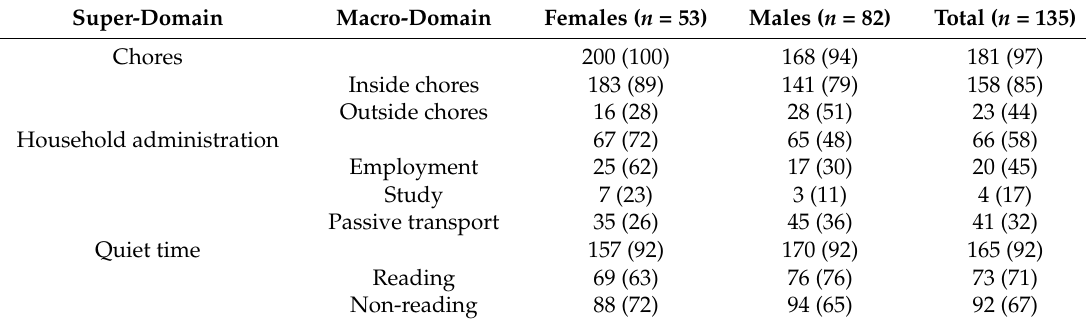
Table 2. Baseline MARCA recall use of time data presented using arithmetic means for super- and macrodomains (in